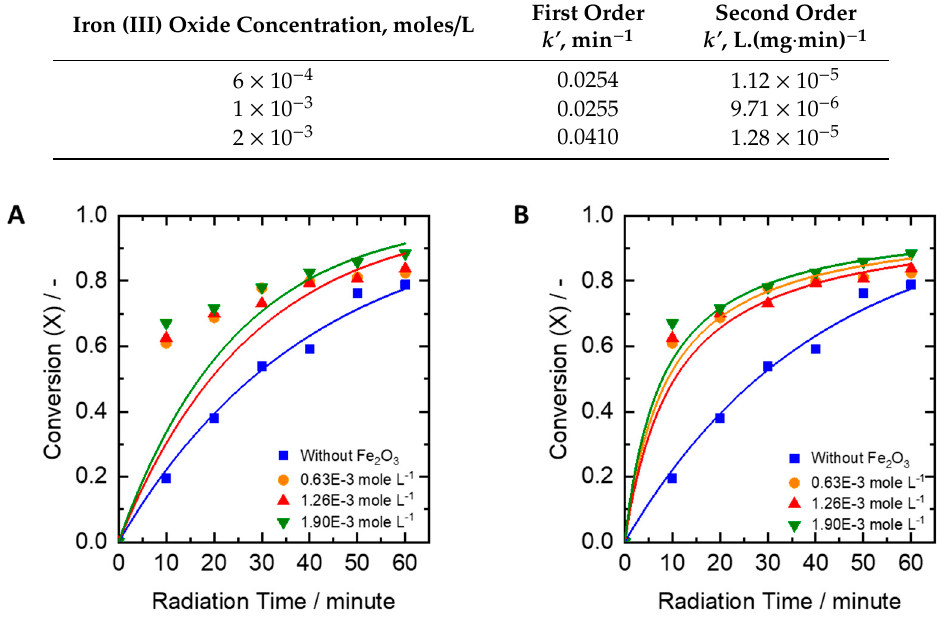
Figure 7. Fitting conversion data with reaction model order one ( A ) and order two ( B ). Conditions: pH 6, 0.61 moles / L concentration of H 2 O 2 , and 30-watt lamp power.